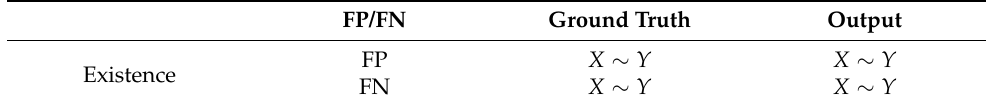
Table 8. Descriptions of FP and FN in correlation.